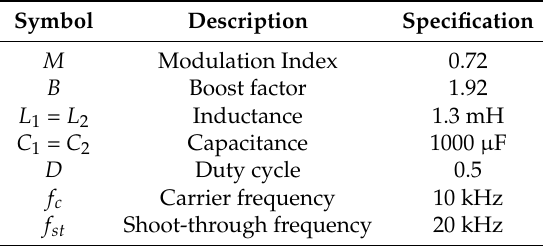
Table 2. Parameters of Z-source